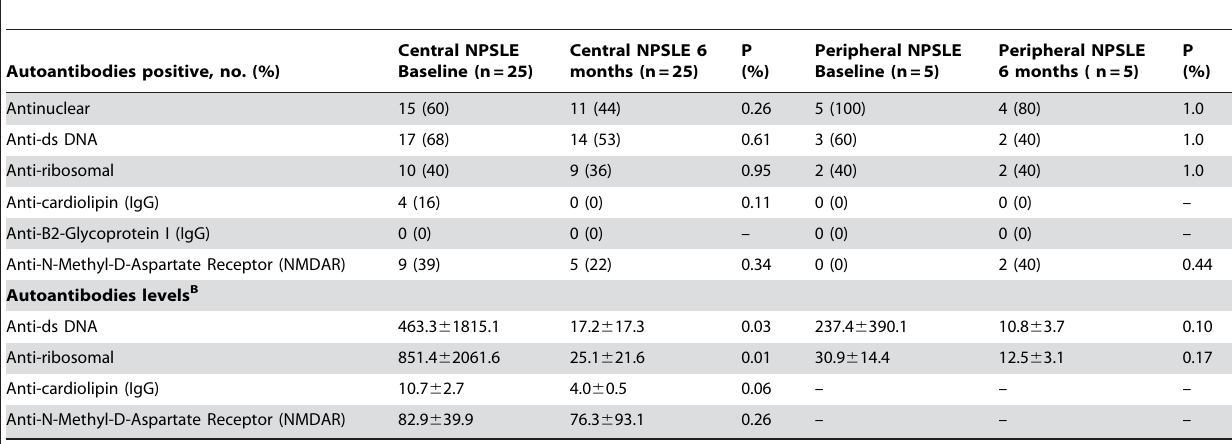
Table 5. Prevalence and levels of autoantibodies in cerebrospinal fluid of patients with central and peripheral NPSLE at baseline and 6 months